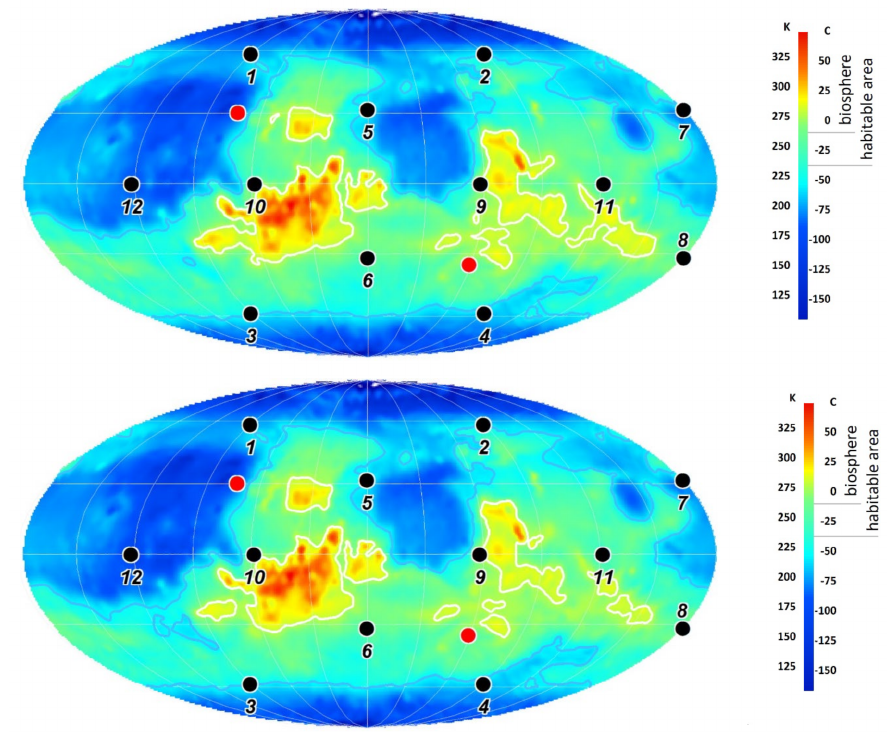
Figure 24. Twelve 8.3 GT “asteroids” ( top ), Twelve 125 kT “factories” ( bottom ) (after 100 Mar- tian